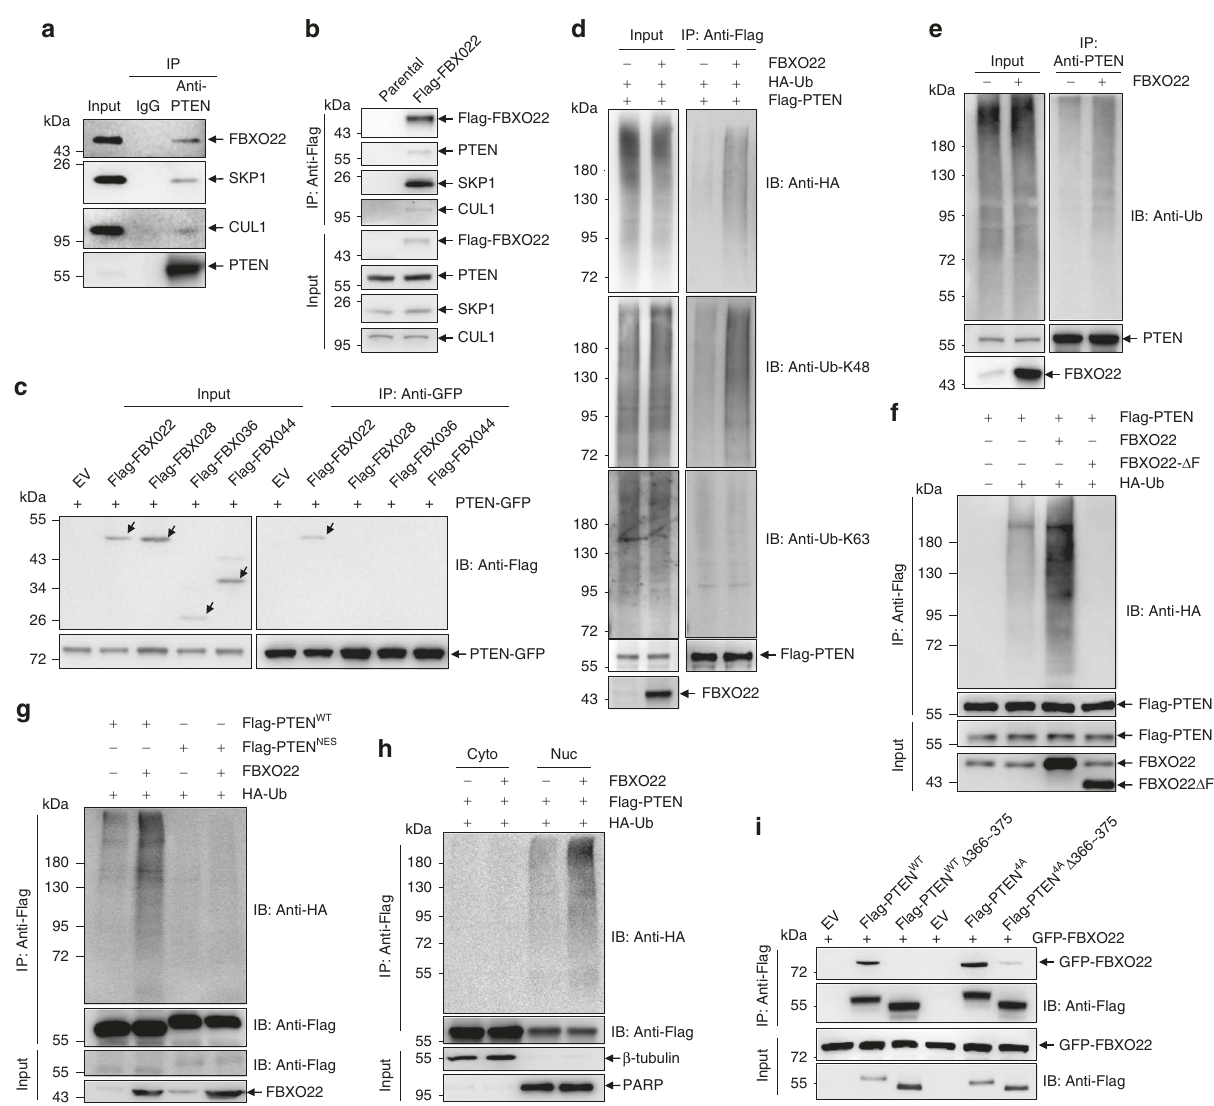
Fig. 2 FBXO22 ubiquitylates nuclear but not cytoplasmic PTEN. a Western blots of indicated proteins in the input and immunoprecipitates of IgG or anti- PTEN antibody in 293T cells. b 293T cells with a Flag tag knocked into the FBXO22 locus together with parental 293T cells were subjected to immunoprecipitation with an anti-Flag antibody. Western blots of indicated proteins in the input and immunoprecipitates are shown. c 293T cells co- transfected with PTEN-GFP and Flag-tagged proteins were subjected to immunoprecipitation with an anti-GFP antibody. Western blots of Flag- and GFP- tagged proteins in the input and immunoprecipitates are shown. d – g 293T cells transfected with the indicated plasmids were treated with 10 μ M MG132 for 6 h, harvested, and submitted to in vivo ubiquitination assay, followed by Western blot analysis with antibodies as indicated. h 293T cells transfected with the indicated plasmids were treated with 10 μ M MG132 for 6 h, harvested, and submitted to subcellular fractionation into cytoplasmic (Cyto) and nuclear (Nuc) fractions, followed by in vivo ubiquitination assay and Western blot analysis. i 293T cells co-transfected with GFP-FBXO22 and Flag-tagged PTEN derivatives were subjected to immunoprecipitation with an anti-Flag antibody. Western blots of Flag- and GFP-tagged proteins in the input and immunoprecipitates are shown.The experiments shown in a – i were repeated three times with similar results, and the results of one representative experiment are shown. Source data are provided as a Source Data fi